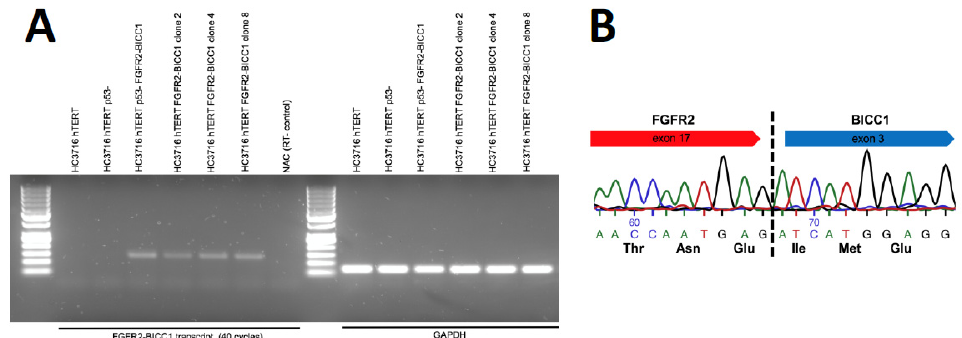
Figure 5. RNA validation of the FGFR2–BICC1 fusion transcript ( A ) RNA was isolated from the clonal cell lines and reverse transcribed. The cDNA was used to detect the FGFR2–BICC1 fusion using forward and reverse primers that map to exon 17 of FGFR2 and exon3 of BICC1 , respectively. GAPDH was used as a control. ( B ) Sanger sequencing of the exon–exon junction showing an in-frame fusion transcript.